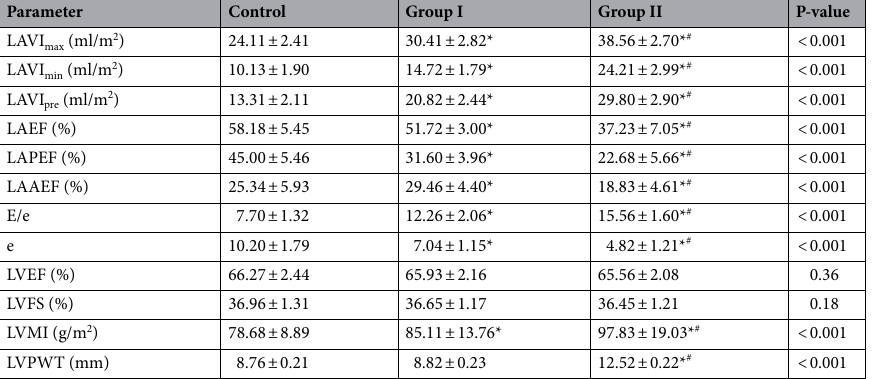
Table 3. Conventional echocardiographic parameters. Data are presented as mean ± standard deviation. LAVI max left atrial maximal volume index, LAVI min left atrial minimum volume index, LAVI pre left atrial presystolic volume index, LAEF left atrial ejection fraction, LAPEF left atrial passive ejection fraction, LAAEF left atrial active ejection fraction, LVEF left ventricular ejection fraction, LVFS left ventricular fractional shortening, LVMI left ventricular mass index, LVPWT left ventricular posterior wall thickness. *Compared with control group, P < 0.05. # Compared with group I, P <